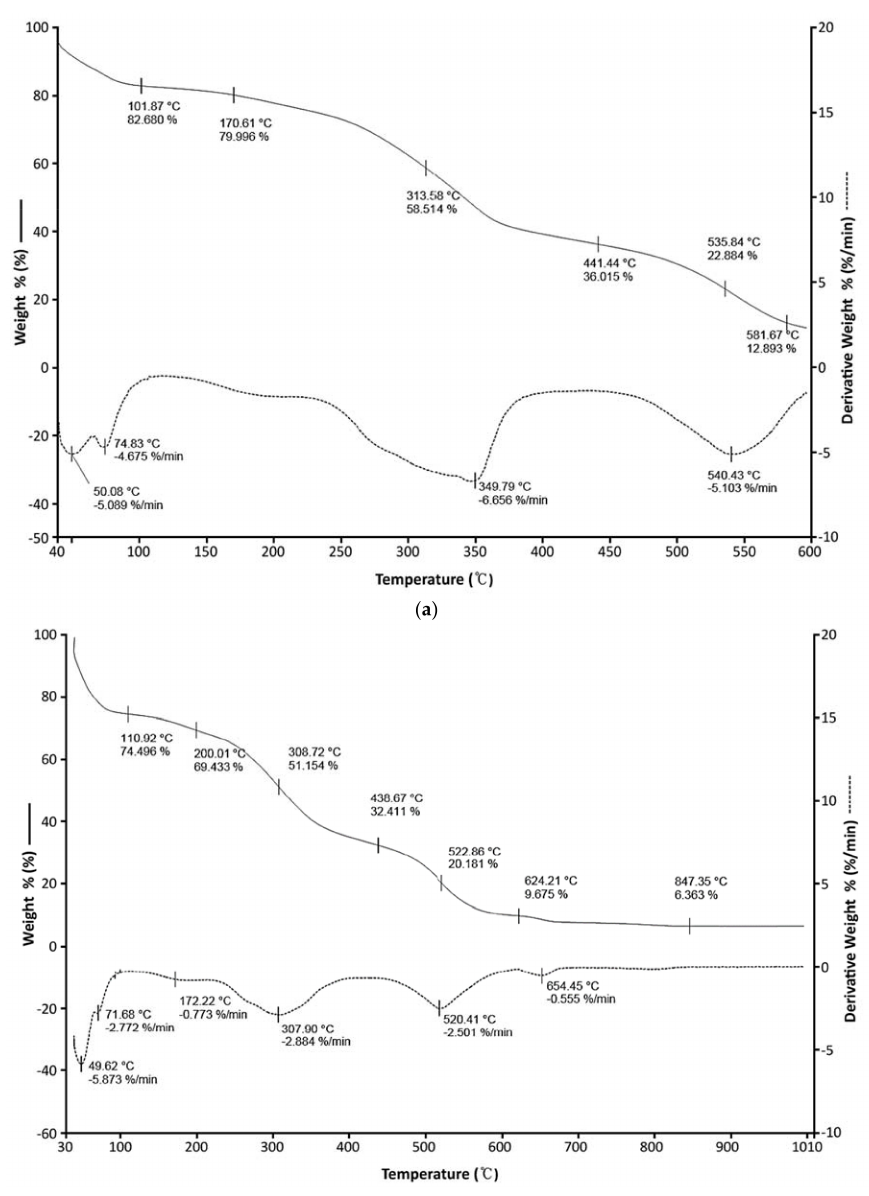
Figure 3. ( a ) Compost at 600 ◦ C, 20 ◦ C/min; ( b ) Compost at 1000 ◦ C, 10 ◦